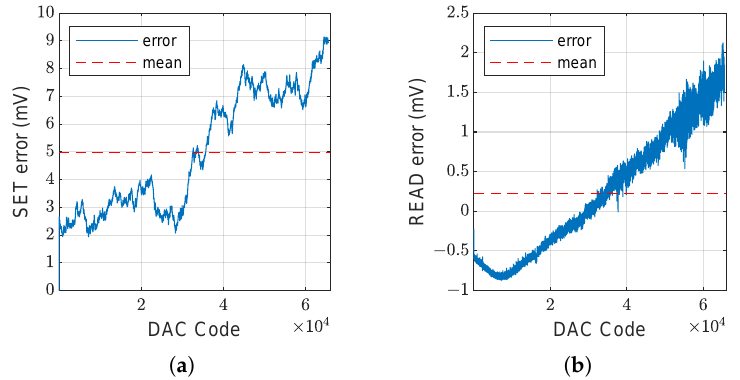
Figure 5. Characterization of the set ( a ) and read ( b ) error with no output